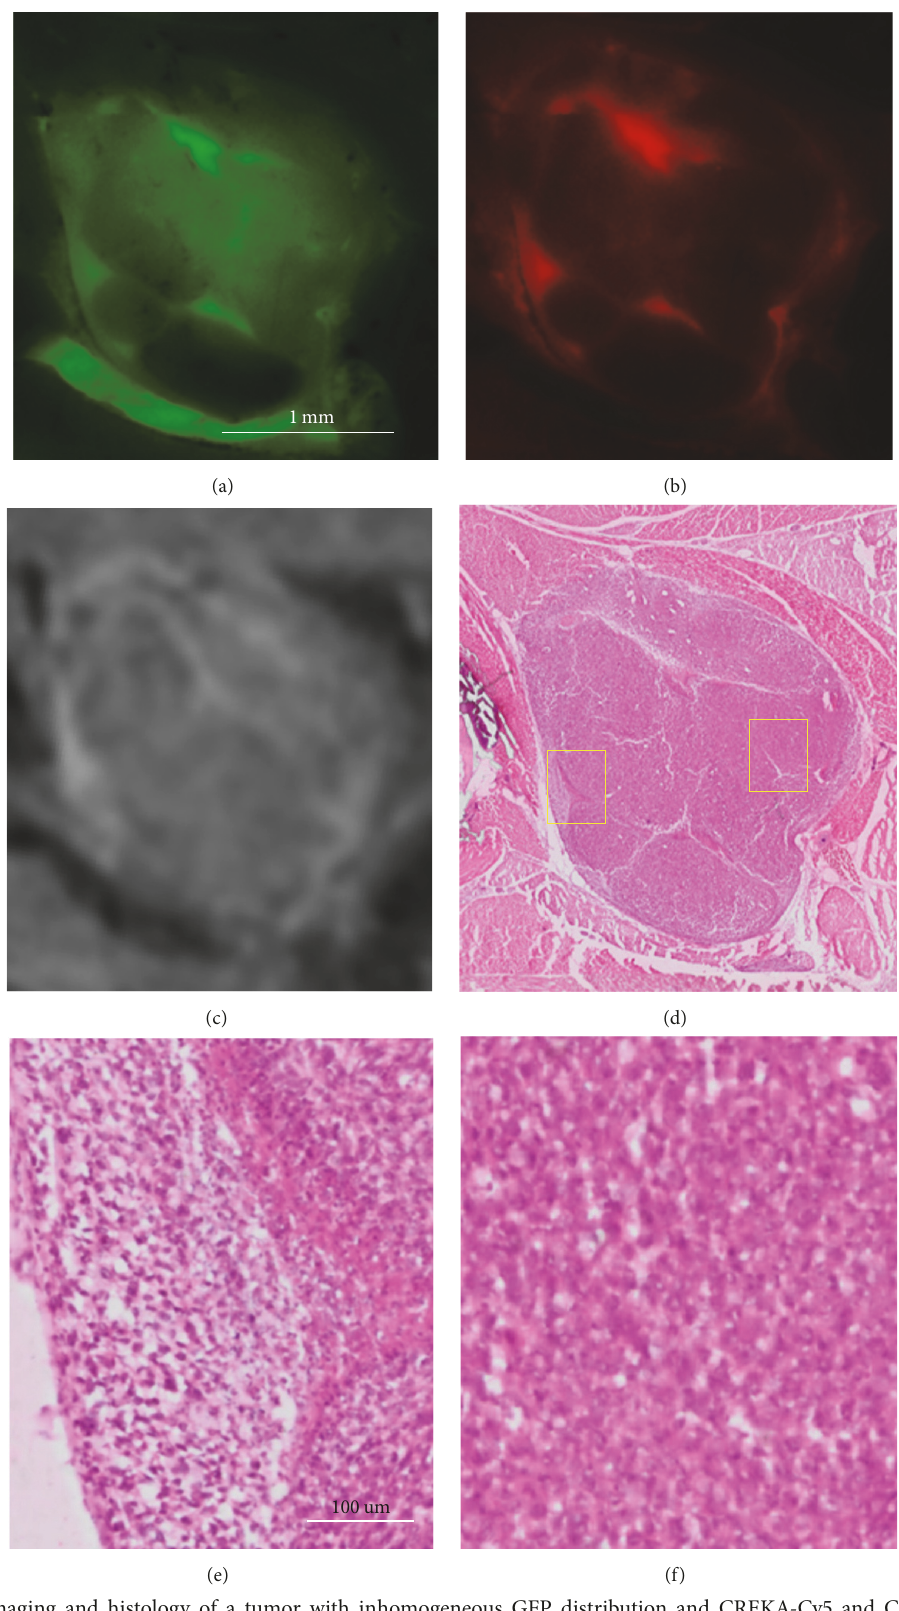
Figure 11: cryo-imaging and histology of a tumor with inhomogeneous GFP distribution and CREKA-Cy5 and CREKA-Gd labeling. The tumor consisting of green fluorescence GFP, red fluorescence CREKA-Cy5, MRI CREKA-Gd, and histology H&E is shown in (a–d), respectively. Magnified histology images in (e) and (f) are from the left and right regions identified in (d) with high and low labeling, respectively. (e) contains tumor cells and a blood vessel, presumably leading to hyperintense labeling. (f) shows a region of low labeling signal intensity comprised of noncancerous tissue. Scale bar = 100 𝜇